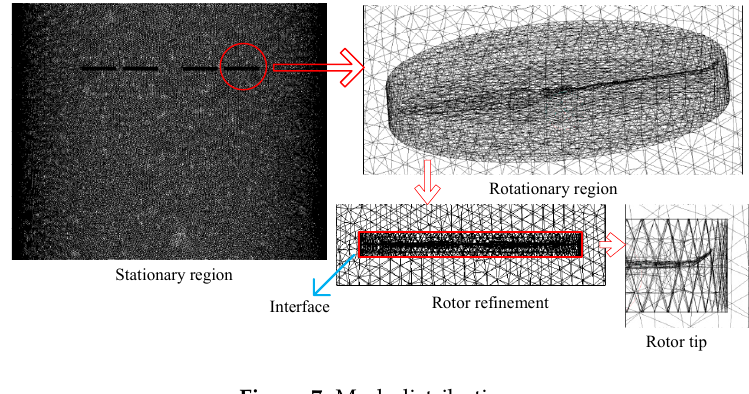
Figure 7. Mesh distribution.